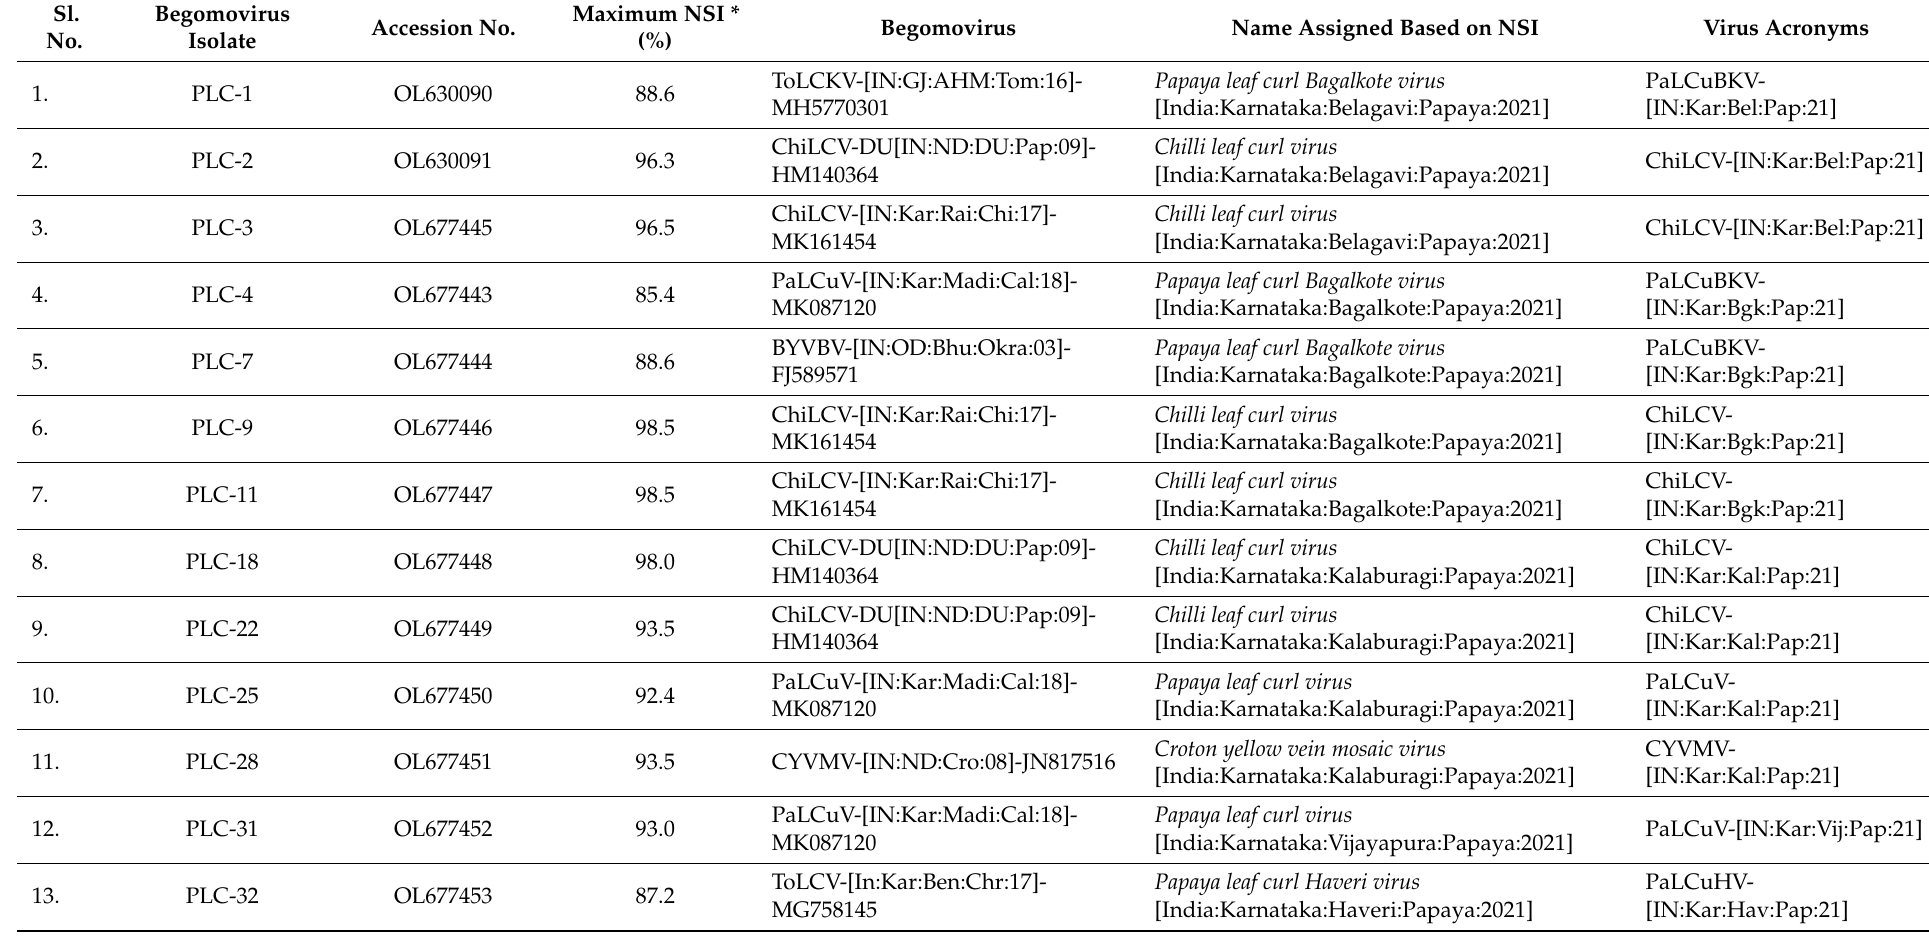
Table 2. Maximum percentage nucleotide sequence identity of DNA-A component of begomoviruses isolated from papaya with other known begomovirus isolates and assigning acronyms to the